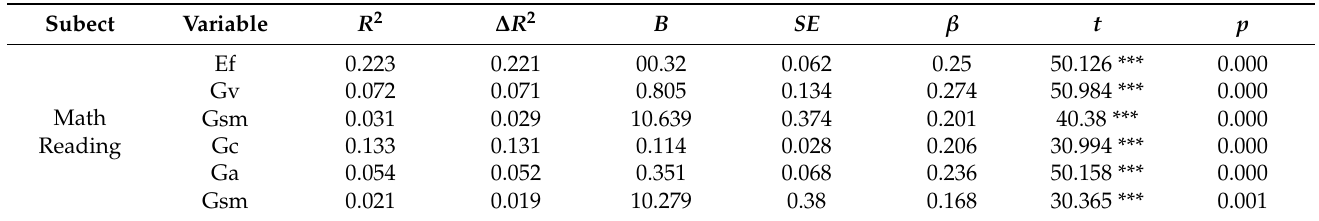
Table 3. Effects of cognitive abilities on Mathematics and Chinese students scores in math and reading (grades 1 to 6).